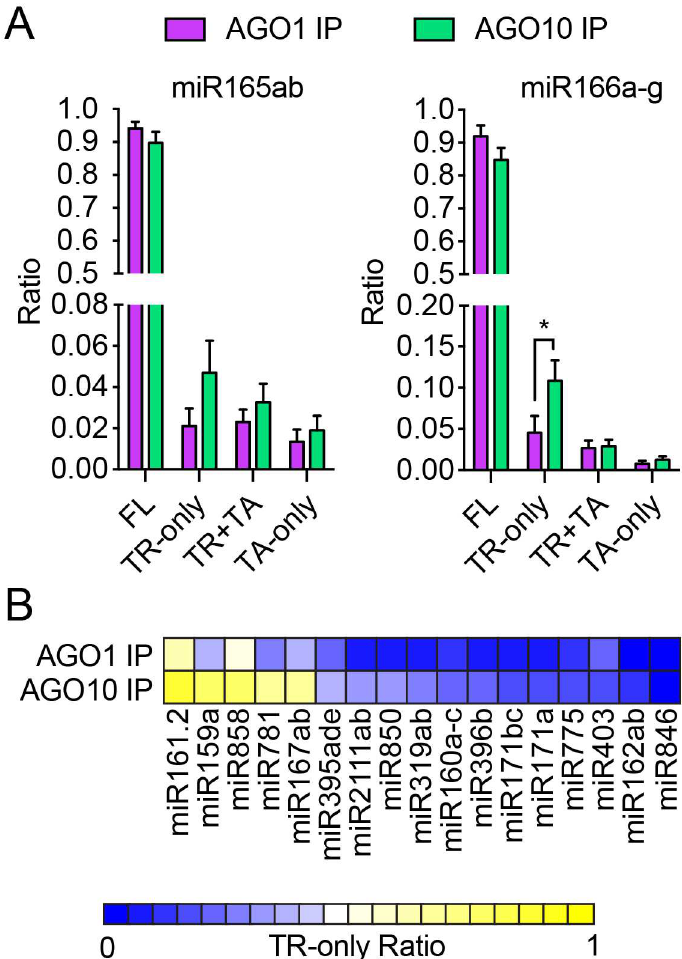
Fig 7. 3 0 truncated miRNAs in AGO10 OE are preferentially bound by AGO10. AGO1 and AGO10 were separately immunoprecipitatedfrom AGO10 OE S1 , and the associatedsmall RNAs were subjectedto high- throughputsequencing. Three biologicalreplicates were performed, and the error bars represent standard deviations. * p < 0.05. (A) Proportions of varioustypes of miR165/6species in AGO1 IP and AGO10 IP. For miR165ab,the increase in TR-only specieshad a p -valueof 0.065. (B) The TR-only ratio of variousmiRNAs in AGO1 IP and AGO10 IP. The TR-only ratio is the proportionof TR-only species in total species for each miRNA. Seventeen of the top 48 most abundantmiRNAs are shown; they were the only ones with statistically significantdifferences in the TR-only ratio in AGO1 IP and AGO10 IP. All showed reducedTR-only species in AGO10 IP except for miR403. Underlying data can be found in the GEO databaseas series GSE58138. The raw data for panels (A and B) can be found in S1 Data